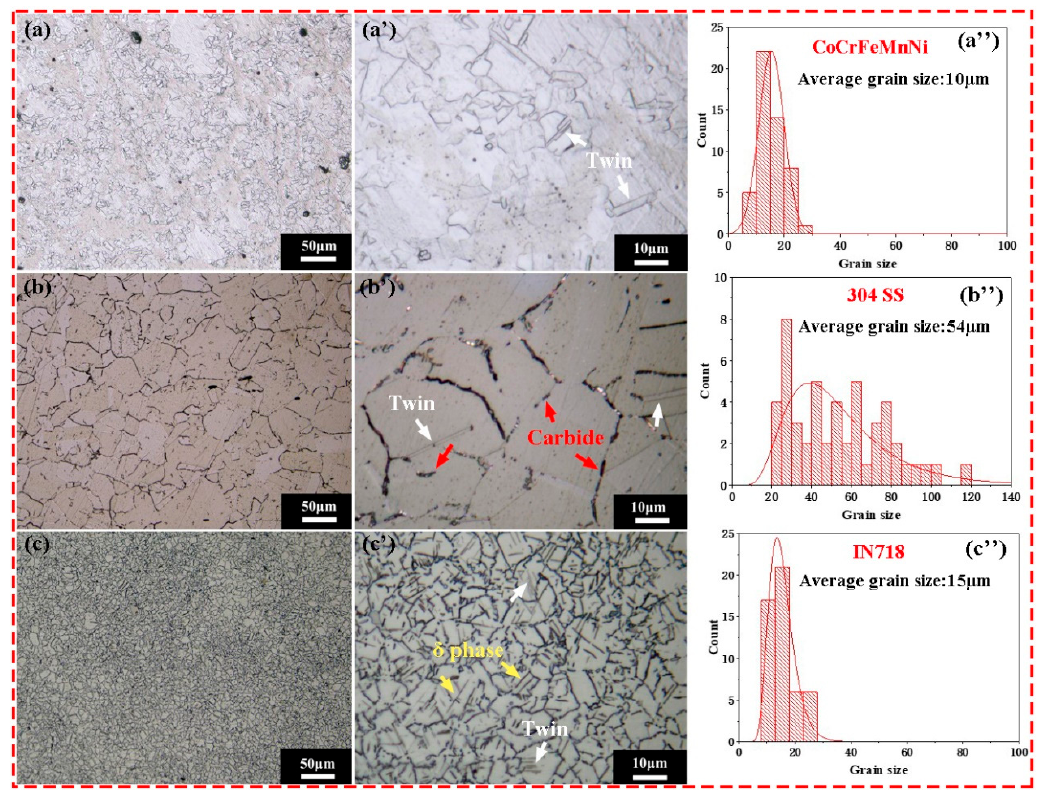
Figure 2. Microstructure of CoCrFeMnNi ( a – a ′′ ), 304 SS ( b – b ′′ ) and IN718 ( c – c ′′ ). ( a , a ′ , b , b ′ , c , c ′ ) optical microscopy images; ( a ′′ , b ′′ , c ′′ ) histograms reporting the grain size distribution of the alloys.